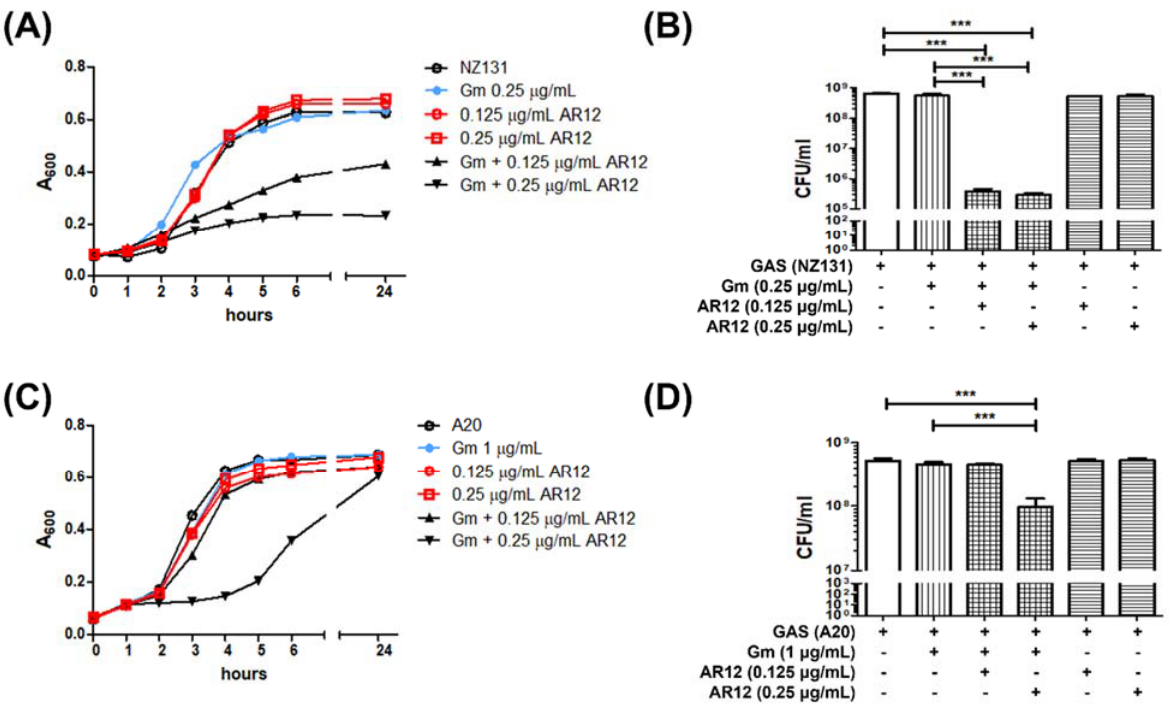
Figure 6. The AR-12 enhanced in vitro antibacterial effect of gentamicin against group A Streptococcus . GAS NZ131 cells ( A , B ) (5 × 10 6 CFU/mL) cultured in THY medium were treated with 0.25 μ g/mL of gentamicin (Gm), 0.125 or 0.25 μ g/mL of AR-12, or combinations of 0.25 μ g/mL of Gm and 0.125 μ g/mL or 0.25 μ g/mL of AR-12. In the experiment of GAS A20 strain influenced by Gm and AR-12, the concentration of Gm was replaced by 1 μ g/mL, and concentrations of AR-12 were the same as previously described ( C , D ). GAS cultures were incubated at 37 °C, and the A 600 was measured at various time points over a period of 24 h ( A , C ). One of three experiments is represented. The exact bacterial numbers were determined at 4 h by CFU-based assay ( B , D ). The results of the three experiments are represented and expressed as the mean ± standard deviation. Treatment groups were compared for significance using ANOVA. *** p < 0.001 compared with the relative groups as shown in the